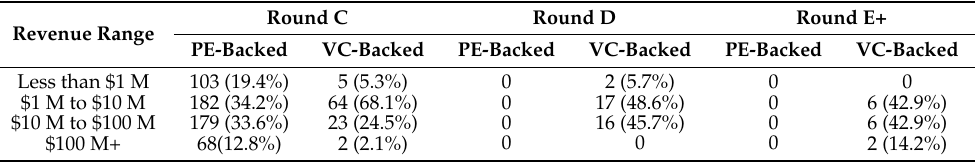
Table 6. Number of Startups by the Latest Reported Funding Round and Revenue Range Detailed for PE or VC Funding.